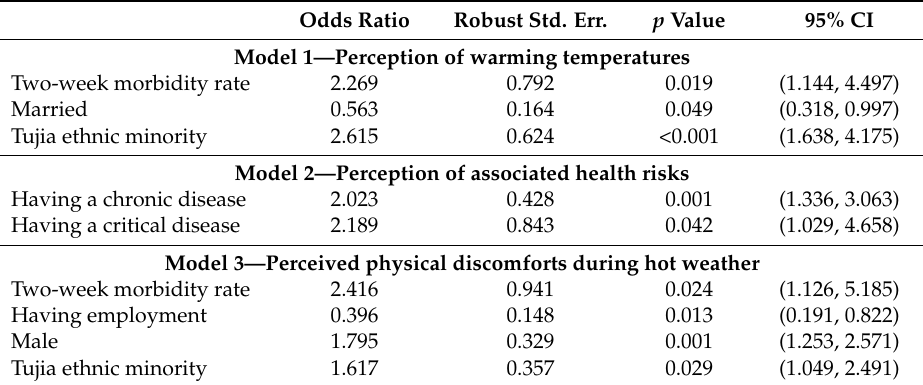
Table 3. Logistic regression models for the perceptions with ORs of the factors. Odds Ratio Robust Std. Err.